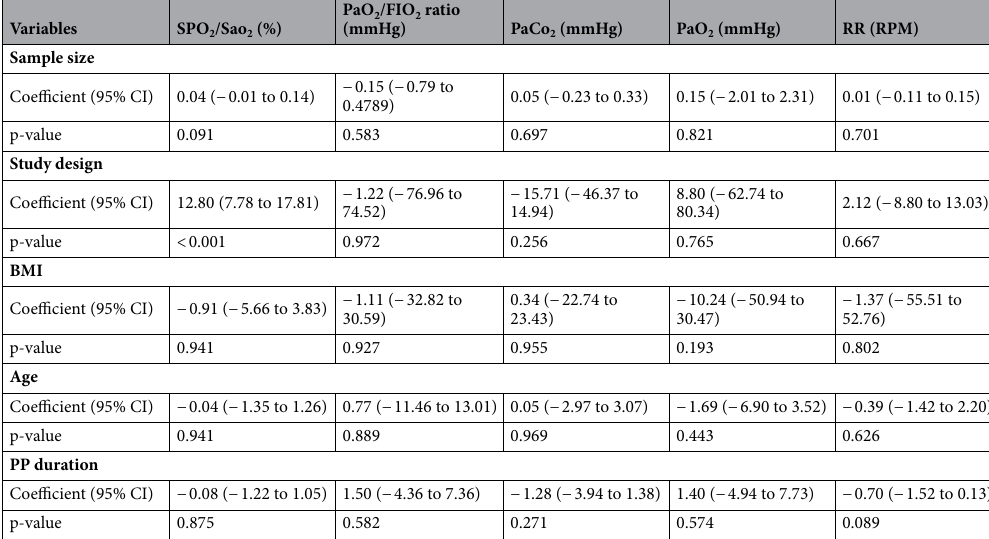
Table 4. Results of the univariate meta-regression analysis on the heterogeneity of the determinants. CI confidence interval, mmHg millimeter of mercury, PMD pooled mean difference, PaO 2 partial arterial oxygen, FIO 2 fractional inspiratory oxygen, Sao 2 oxygen saturation (arterial blood), RR respiratory rate, RPM respiration per minute, Study design before–after design = 1; quasi-experimental design = 2.